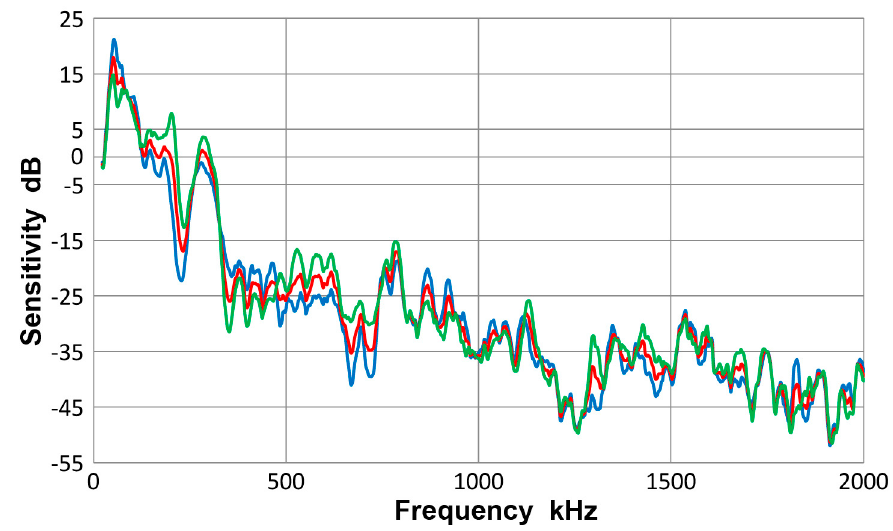
Figure 14. Receiving sensitivity of PAC R6a sensor. Red -averaged guided wave sensitivity, blue -Lamb waves for 12.7 and 6.4 mm plates, green -bar waves for 12.7 and 6.4 mm bars.